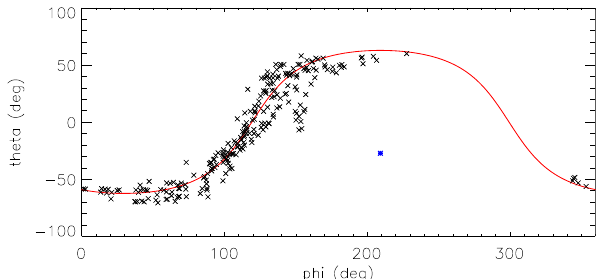
Figure 1. An example of a θ - φ diagram. The direction normal to the PMS plane is displayed by the blue “ ∗ ” and the plane perpendicular to it is represented by the red curve. The black scatter points are the magnetic field vectors as observed by Wind within the sheath region following an interplanetary shock on 10 January